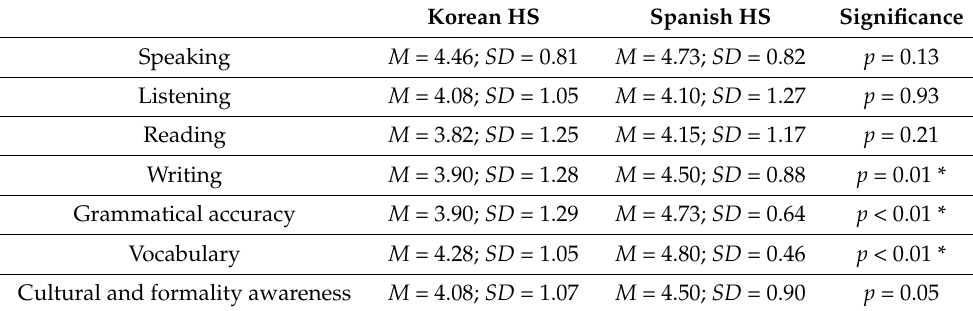
Table 3. Areas that participants desire to improve across HS groups.